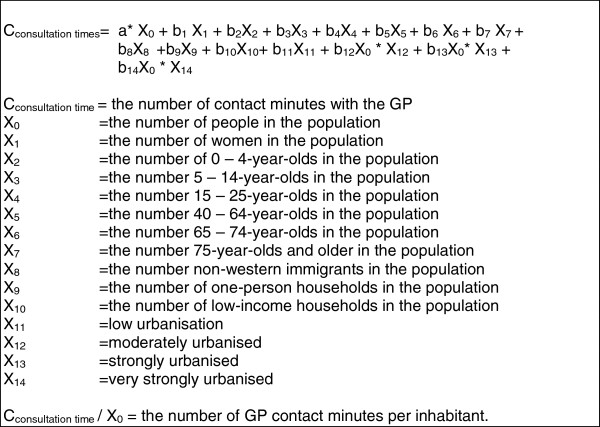
Mathematical model for the expected GP consultation time in minutes per inhabitant.